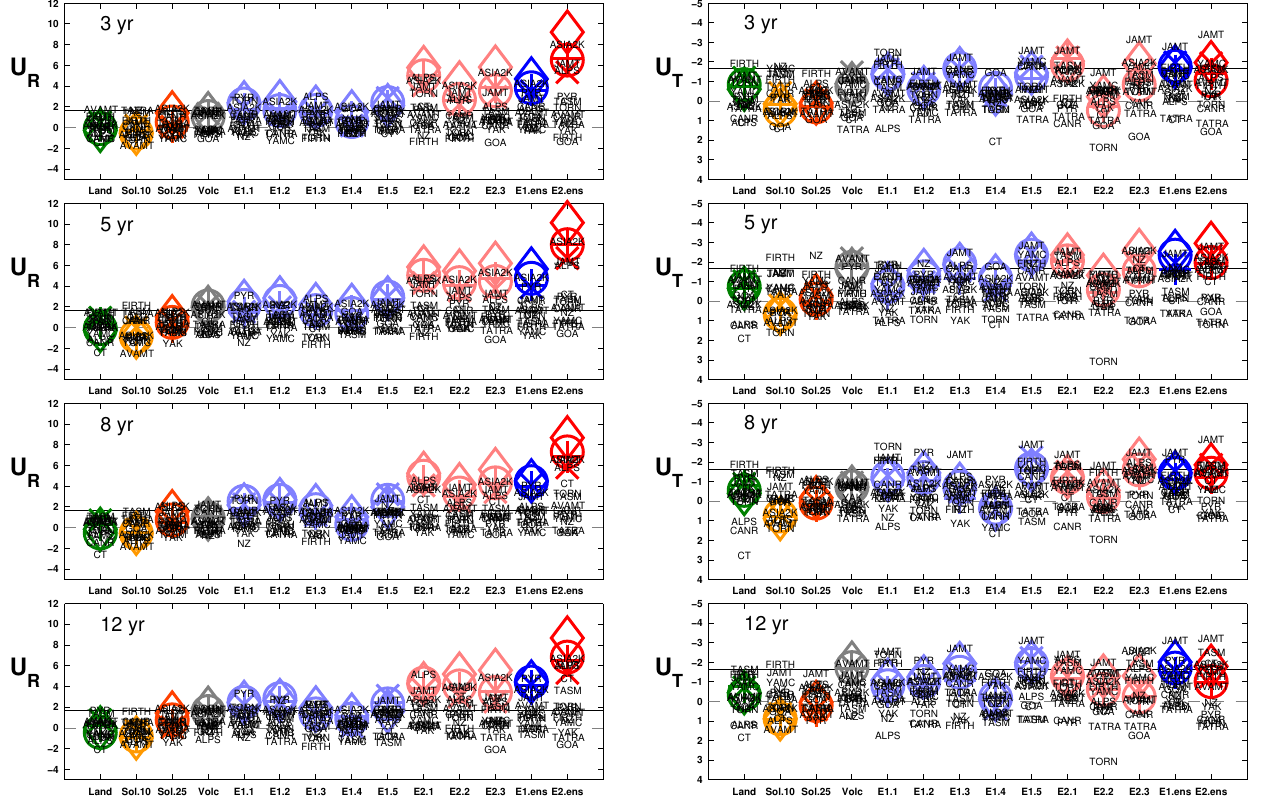
Figure 6. U R and U T statistics from comparisons between simulated temperatures and tree-ring-based temperature observations in the period 1000–1849CE, for time units of 3, 5, 8 and 12 years. Results are shown for single-forcing simulations (land use, low-amplitude solar, high- amplitude solar, volcanic), each individual simulation in the E1 and E2 multiple-forcing ensembles (including low and high solar forcing, respectively), and for the whole E1 and E2 ensembles. U R and U T values for each region are denoted with site short names. Results where all sites are combined are shown with symbols to distinguish between different c j weightings ( (cid:13) equal, non-RCS series). Solid lines show 5% significance levels. Note the reversed vertical axis in the U T